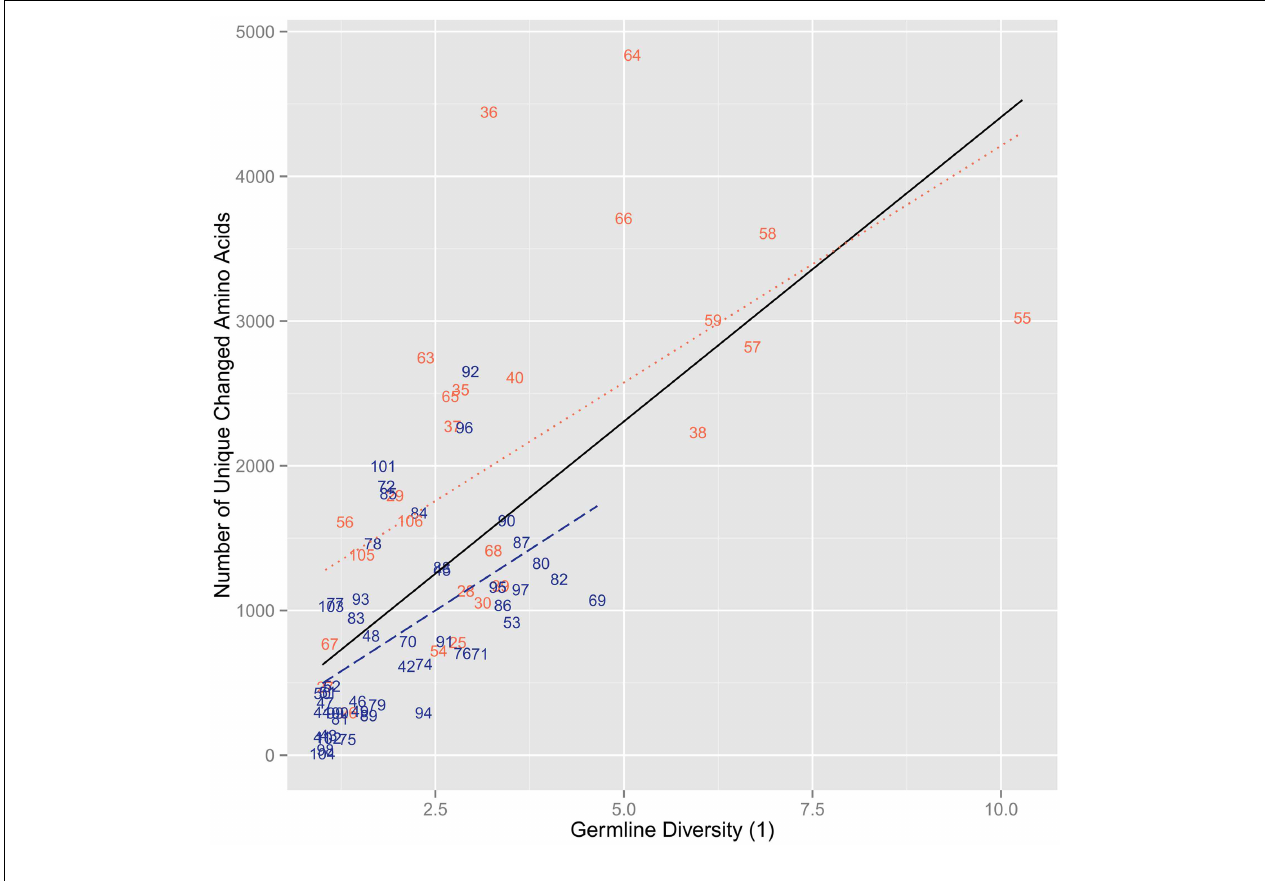
and for CDR positions (dotted red, r 2 = 0.349).We found a significant positive correlation for all positions ( ρ = 0.710, p = 1.41 × 10 − 12 ). By correlating the positions based on FR and CDR, we found a significant positive correlation for both FR ( ρ = 0.668, p = 2.17 × 10 − 7 ) and CDR ( ρ = 0.676, p = 2.18 × 10 − 4